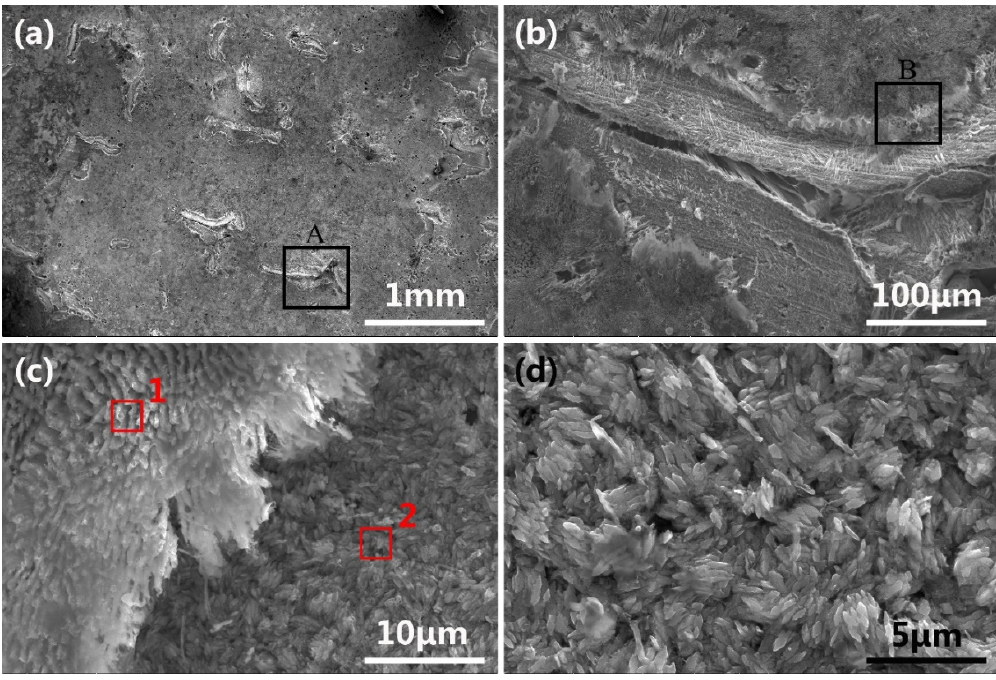
Figure 7. Microstructure of polished steel plate coatings at ( a ) low multiplications, ( b ) Enlarged image of area A in ( a ), ( c ) Enlarged image of area B in ( b ), ( d ) Microscopic image of region 2 in ( c ). Metals 2020 , 10 , x FOR PEER REVIEW